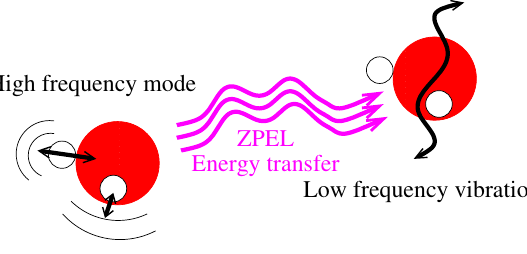
Figure 8. The mechanism of Zero-Point Energy Leakage: the QTB pumps more energy into high frequency modes than into low frequency modes, but the simulation, being classical in prac- tice, will tend to enforce energy equipartition and induce an en- ergy flow from high to low frequency motions. In this this figure the light hydrogen atom (white) vibrate at a high frequency: en- ergy is thus transfered to the low frequency lattice modes mainly involving heavier oxygen (red). This can considerably alter the structure of the system and yield useless